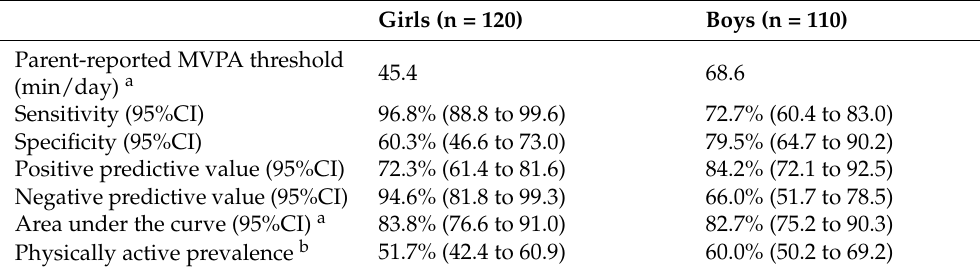
Table 3. Validity to identify children who accumulated ≥ 60 versus <60 min/day of MVPA based on the accelerometry using the parent-reported questionnaire optimal